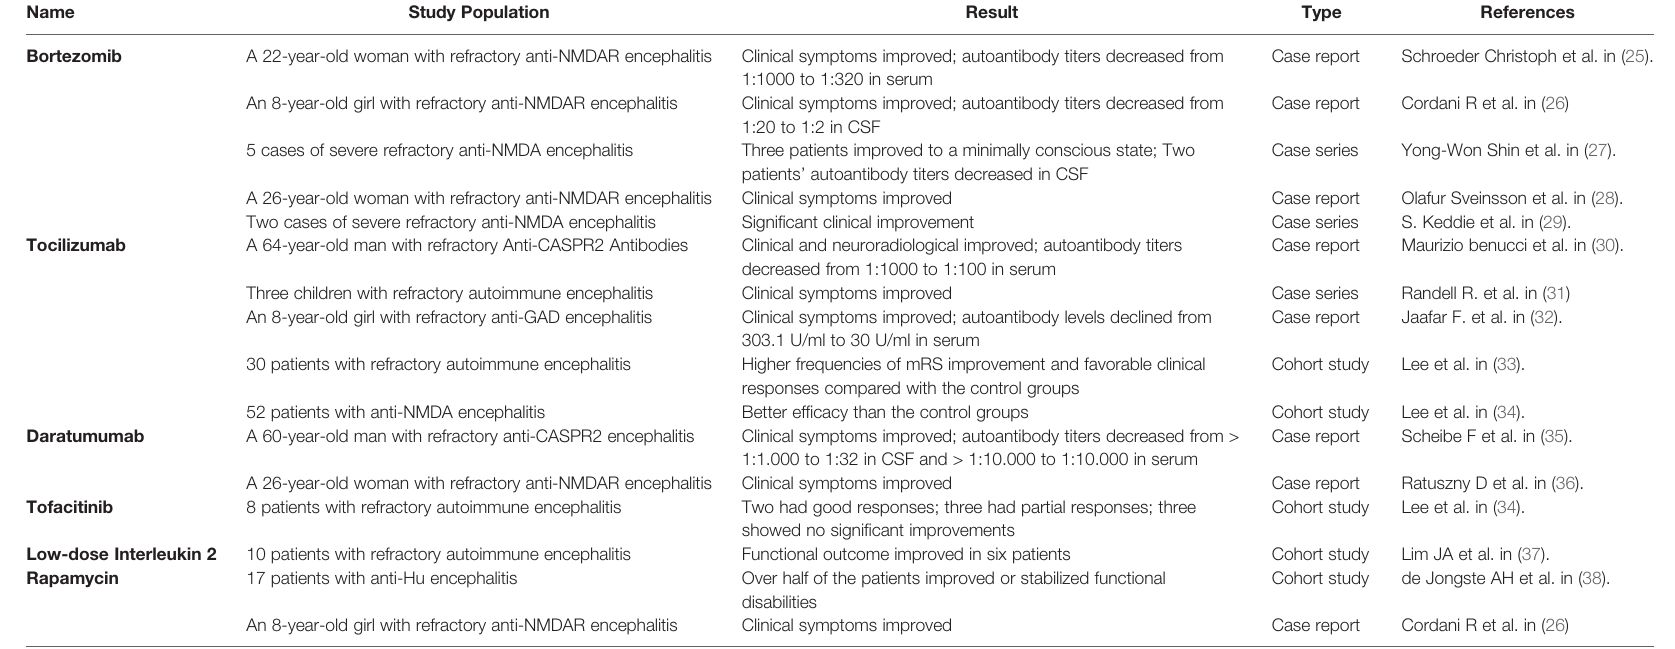
TABLE 2 | Studies on third-line therapy for refractory autoimmune encephalitis.